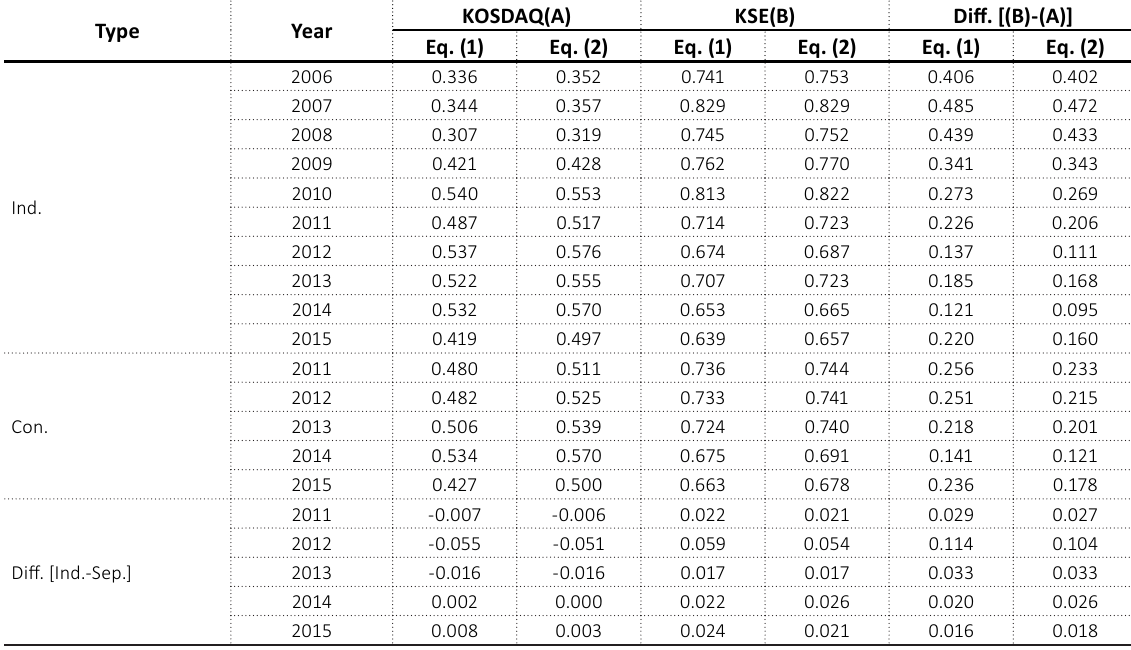
Table 5. Annual time-series trends of adjusted R 2 by listing market